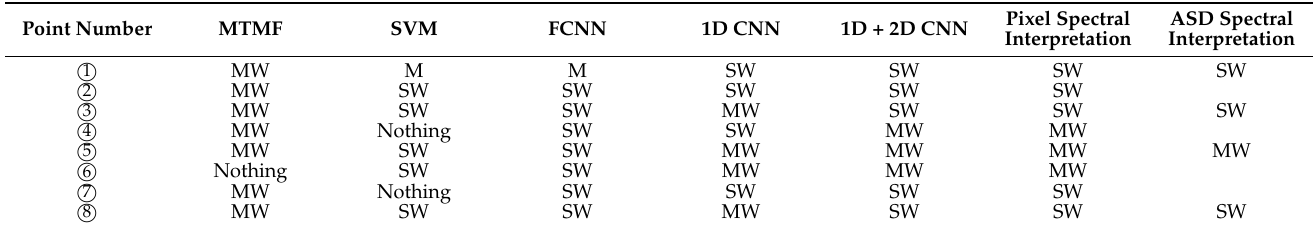
Table 7. A comparison table of the verification point results shown in Figure